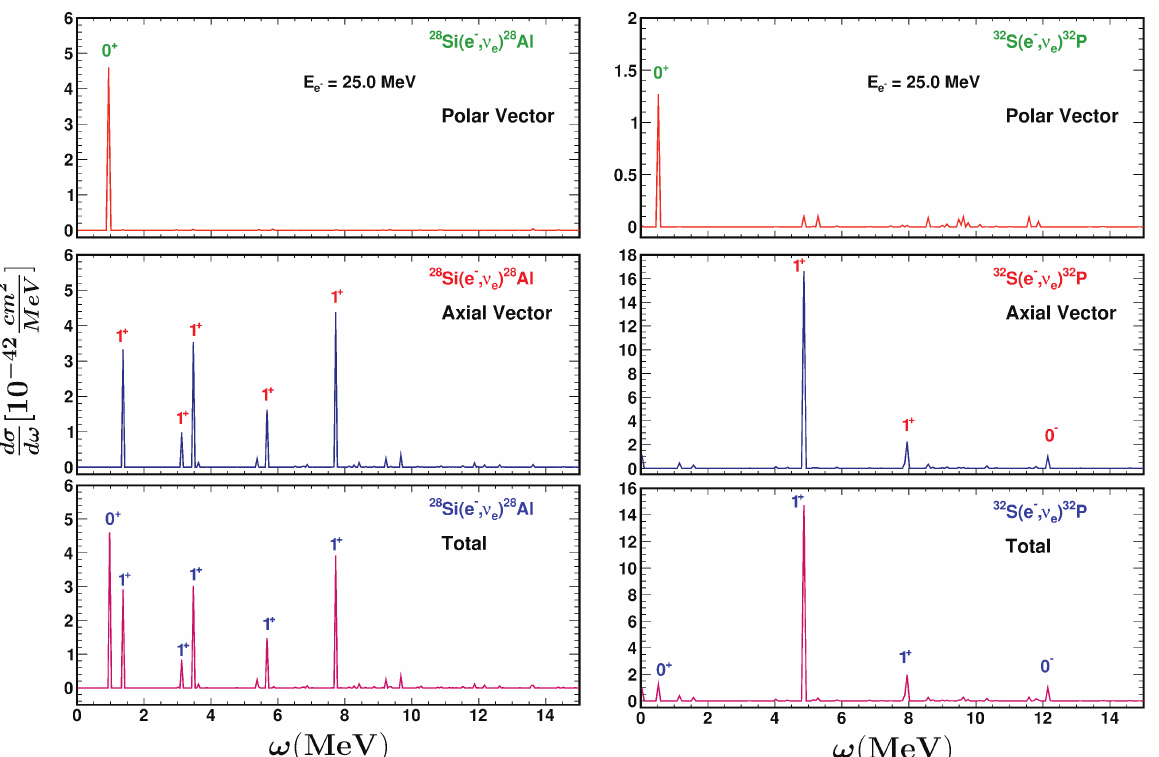
Figure 1. Total differential electron capture cross sections, d σ / d ω , as a function of the excitation energy ω and individual contribution of the Polar-Vector, Λ V , and Axial-Vector, Λ A , operatorss, for the 28 Si and 32 S